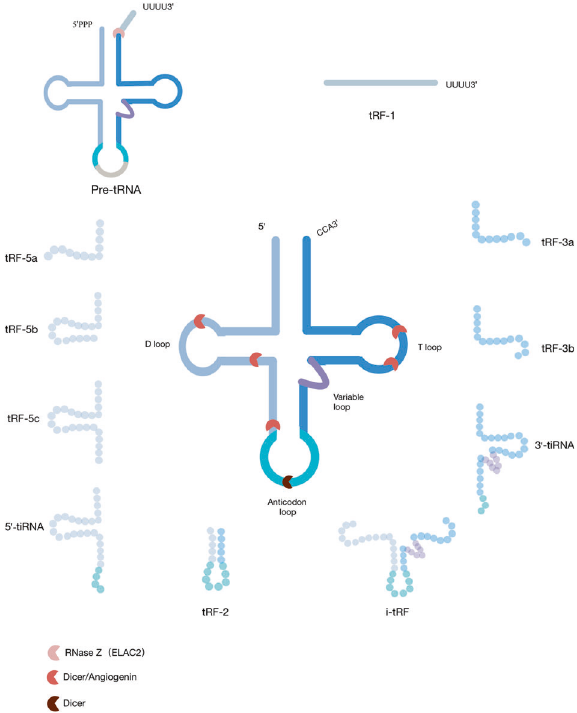
Fig. 1 Classi fi cation of tsRNAs. tRF-1s are derived from the 3 ′ -end of the precursor tRNA. tRF-5s are derived from the 5 ′ -end of mature tRNAs and end at a D-loop or at a stem region between the D-loop and the anti-codon loop. tRF-3s are generated from the T ψ C loop with a “ CCA ” tail. tRF-2s are produced by decomposition of the anticodon loop of tRNA and do not include the typical 5 ′ -end and 3 ′ -end groups. i-tRFs are generated from the internal region of mature tRNAs straddling the anti-codon region with variable length. tiRNAs are almost half the length of mature